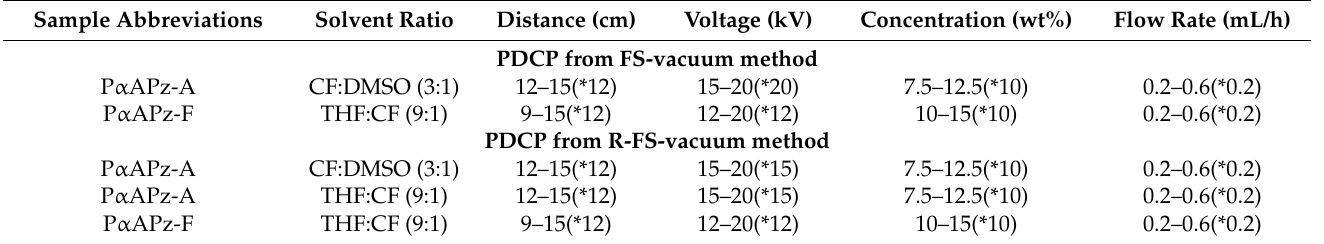
Table 3. Studied electrospinning parameters for P α